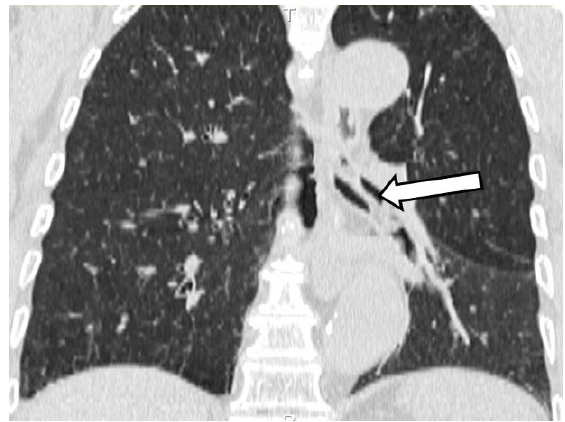
Figure 2. Coronal CT also revealed a large and long mass-like opacity in trachea and left main bronchus.